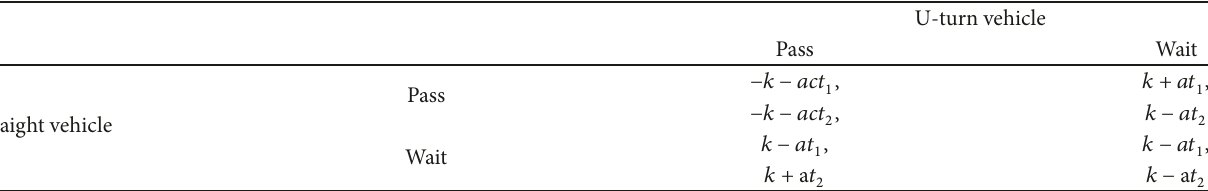
Table 2: Game payoff matrix